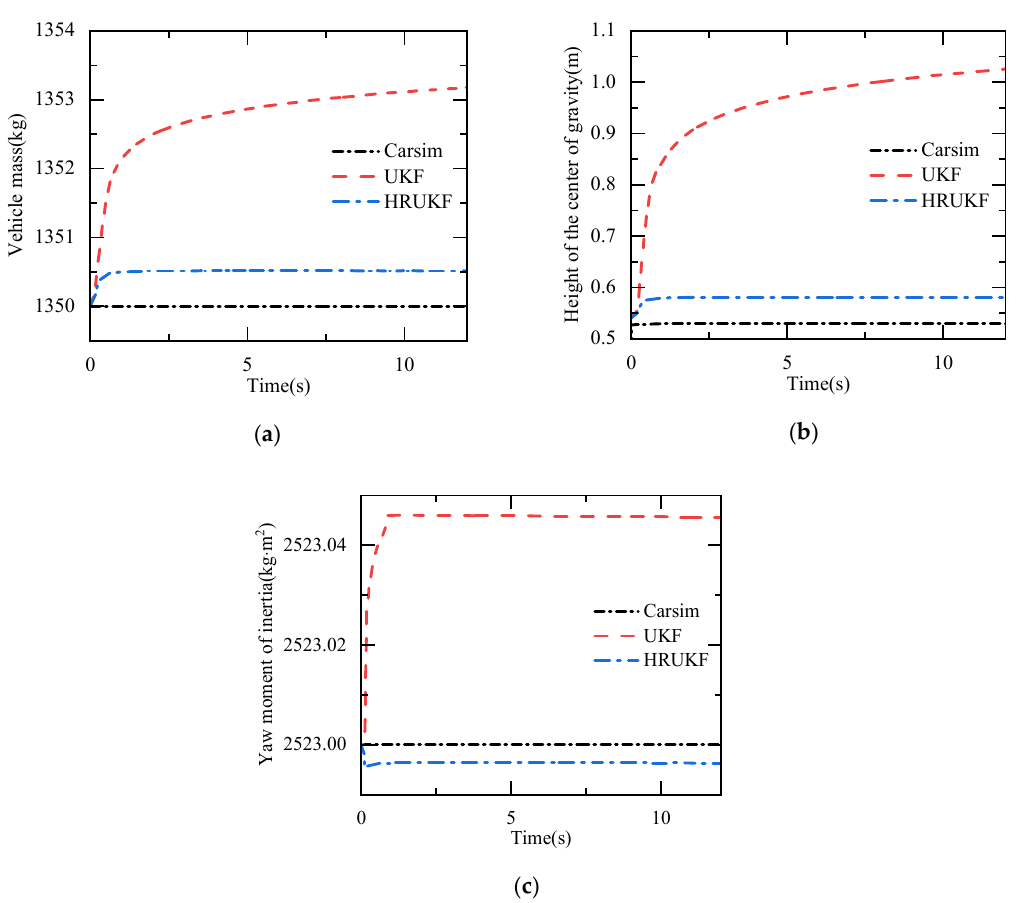
Figure 7. Observation results of vehicle parameters under the straight-line driving condition at constant speed. ( a ) vehicle mass observation results; ( b ) height of the center of gravity observation results; ( c ) yaw moment of inertial observation results.